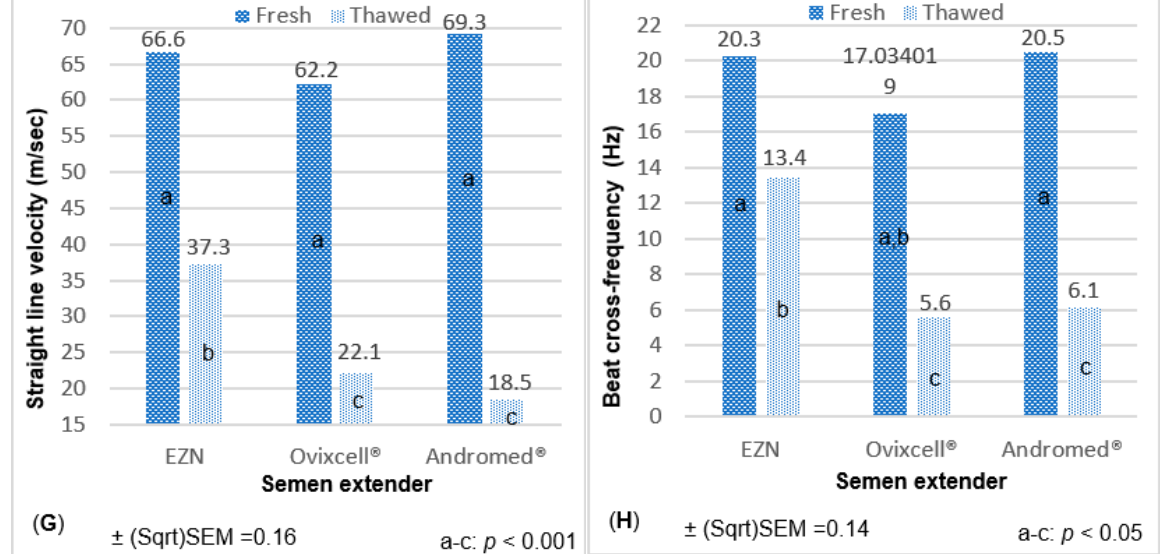
Figure 1. Semen extender X semen processing interaction effects on selected spermatozoa parameters. ( A ) Similar values of spermatozoa (SPZ) viability were observed on fresh semen between different semen extenders (S-EXT), but a less pronounced decrease of the mean percentage of alive SPZ occurred after thawing in EZN S-EXT than in Ovixcell®(OVIX S-EXT) or Andromed®(ANDR S-EXT) extenders, ( B ) the mean percentage of individual (subjective) motility SPZ in fresh semen was independent of S-EXT, but differently affected by freezing-thawing cycle according to the S-EXT, ( C ) contrarily to EZN S-EXT and ANDR S-EXT, no statistical differences of SPZ morphology (mean percentage of abnormal SPZ) was observed between fresh and thawed semen using the OVIX S-EXT. Nevertheless, the mean percentage of abnormal SPZ in fresh semen using OVIX S-EXT was similar to the mean value observed in thawed semen using EZN S-EXT, ( D ) the mean percentage of total motile SPZ (computer-assisted sperm analysis method) in fresh semen was lower using the OVIX S-EXT than EZN S-EXT or ANDR S-EXT. No statistical differences of total motile SPZ were observed between fresh and thawed semen using the EZN S-EXT. Moreover, the mean value of total motile SPZ of the thawed semen using the EZN S-EXT was also similar to the mean values of fresh semen using the other two S-EXT, ( E ) the mean percentage of total progressive motile SPZ was lower in fresh semen using the OVIX S-EXT than using the other two S-EXT. After thawing, the highest value was observed using the EZN S-EXT, ( F ) the mean percentage of rapid SPZ subpopulation of the fresh semen was independent of S-EXT. After thawing, this value is higher using EZN S-EXT than the other two S-EXT. No statistical difference of rapid SPZ subpopulation was observed between thawed semen using EZN S-EXT and fresh semen using OVIX S-EXT, ( G ) Similar mean values of straight-line velocity ( µ m/s) SPZ were observed between the different S-EXT in fresh semen, but a less pronounced decrease occurred after thawing in EZN S-EXT than in OVIX S-EXT or ANDR S-EXT, ( H ) the interaction effect of semen extender X semen processing on beat cross frequency (Hz) was similar to the observed on the rapid SPZ